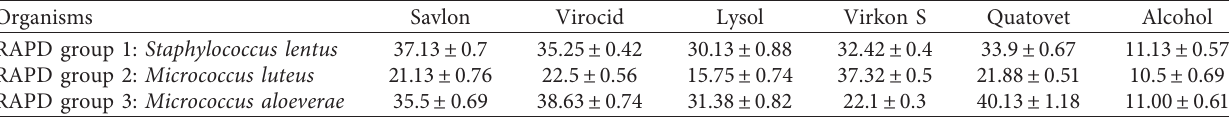
Table 1: Size of the zones of inhibition (mean ± SD) of the organisms produced against each of the disinfectants tested (all data are presented in mm